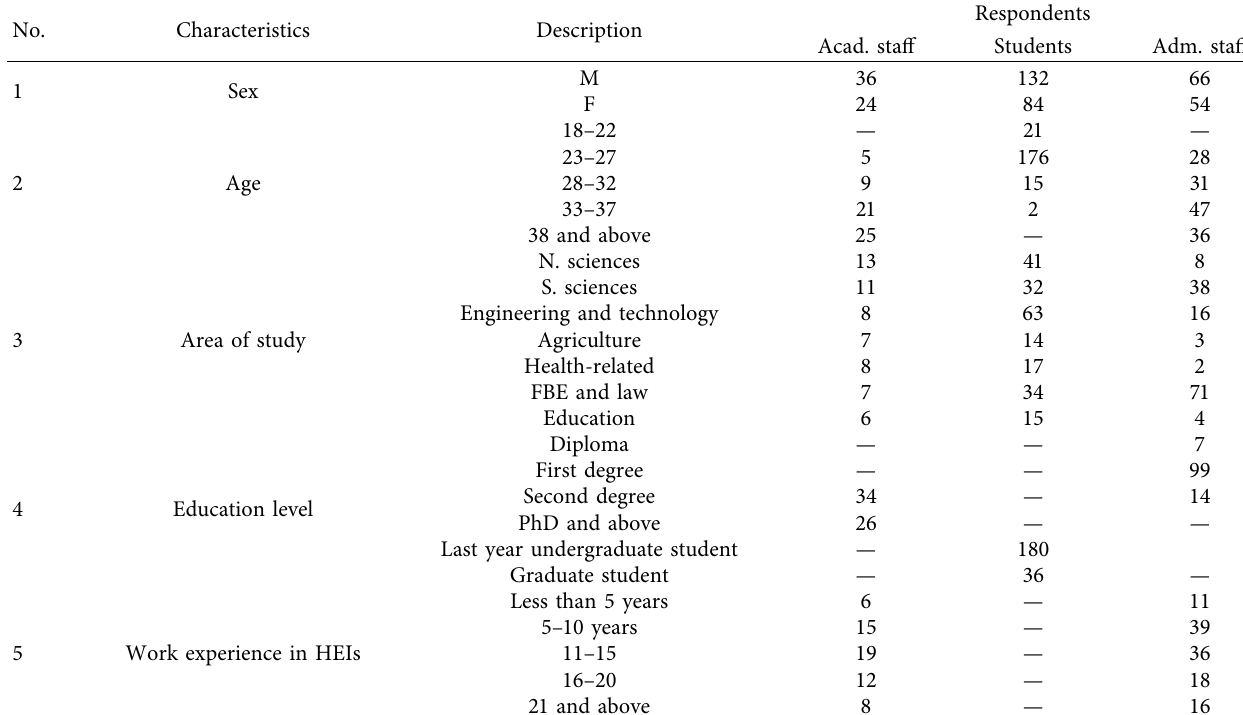
Table 2: Background of the